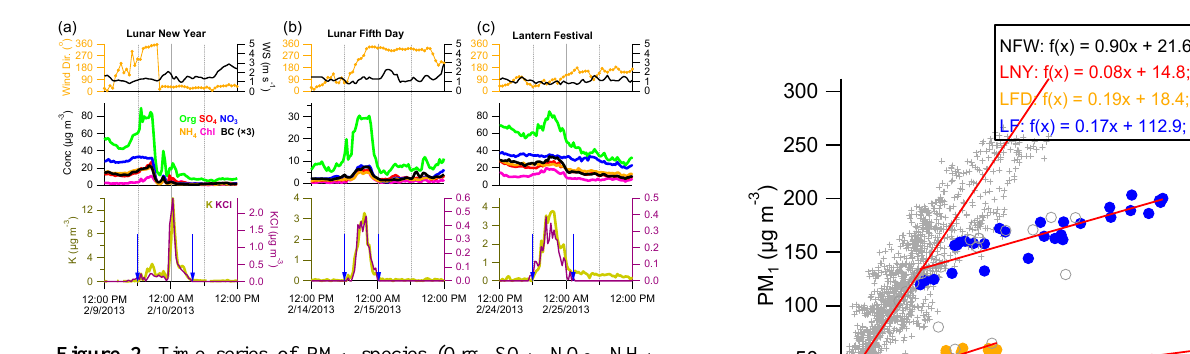
Figure 2. Time series of PM 1 species (Org, SO 4 , NO 3 , NH 4 , Chl, K, KCl, and BC) and meteorological variables (wind direction (100m) and wind speed (8m)) during three firework events, i.e., (a) LNY, (b) LFD, and (c) LF. The two blue arrow lines represent the starting and ending times of firework events.